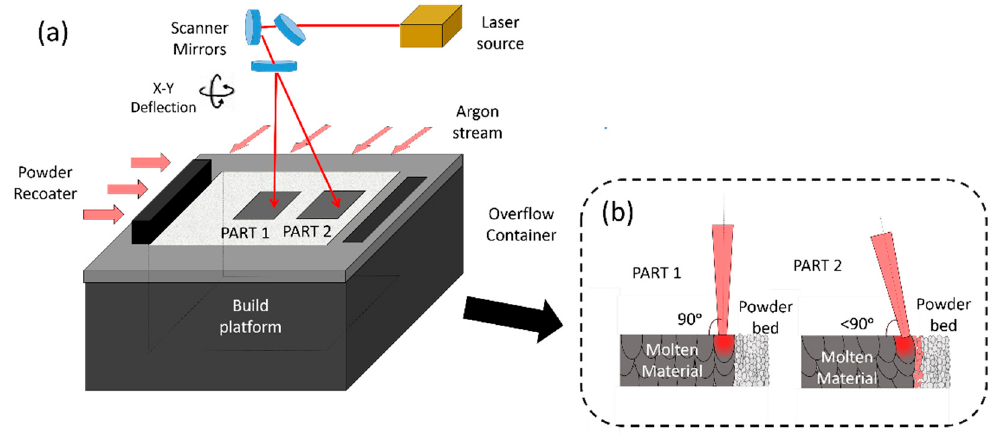
Figure 1. Effect of the incidence angle of the laser: ( a ) Diagram of the Laser Powder Bed Fusion (L-PBF) process showing the scanner operation and the possible angle of incidence in the different areas of the platform; ( b ) Detail of part 1 located in the central area of the platform and part 2 located at one side of the platform.